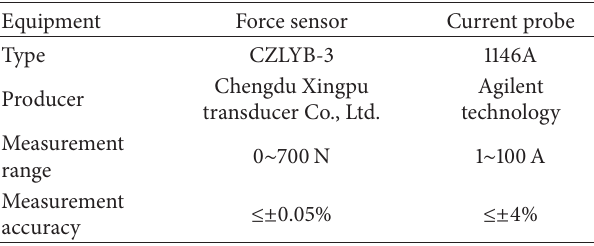
Figure 6: Test bench for HSV. Table 1: Measurement accuracy of main